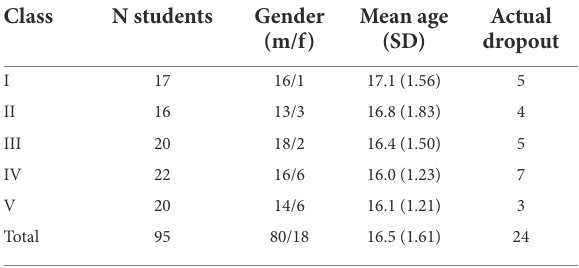
TABLE 1 Descriptive statistics of classes for which dropout predictions were made.